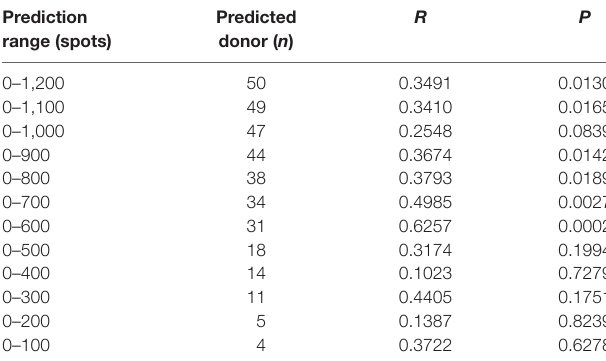
TaBle 2 | Correlation between the observed responses and the predicted responses according to the prediction ranges. Prediction range